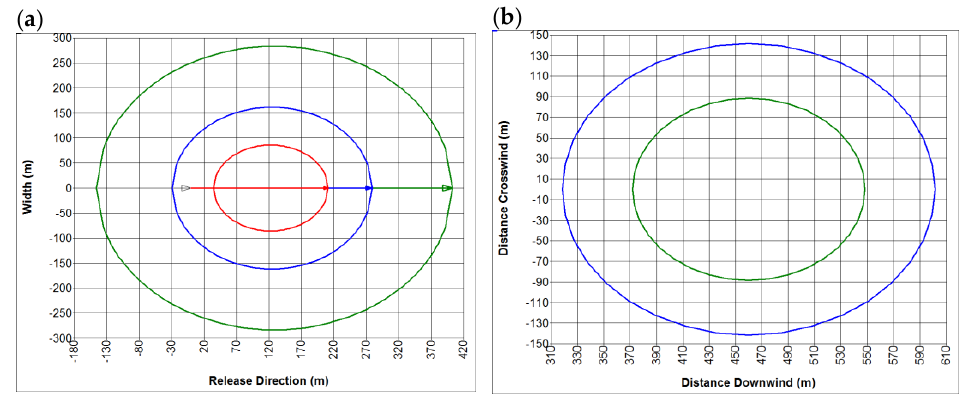
Figure 16. Hazard zones due to a jet fire ( a ) and an explosion ( b ) for a natural gas pipeline (a = 0.2).